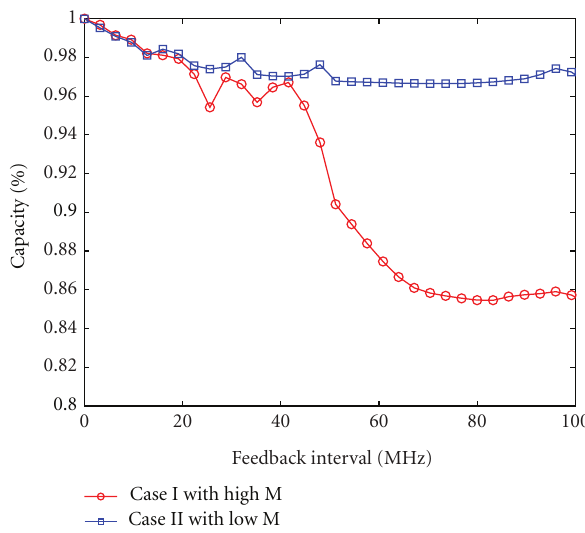
Figure 10: Percentage capacity variation as the transmitted layers feedback interval in frequency